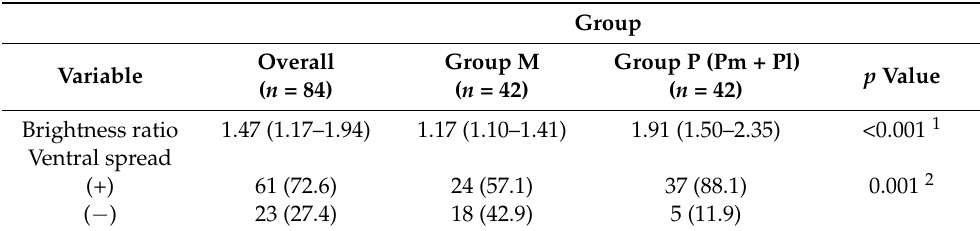
Table 2. Comparison of grayscale brightness ratio and incidence of ventral spread between Group M and Group P.